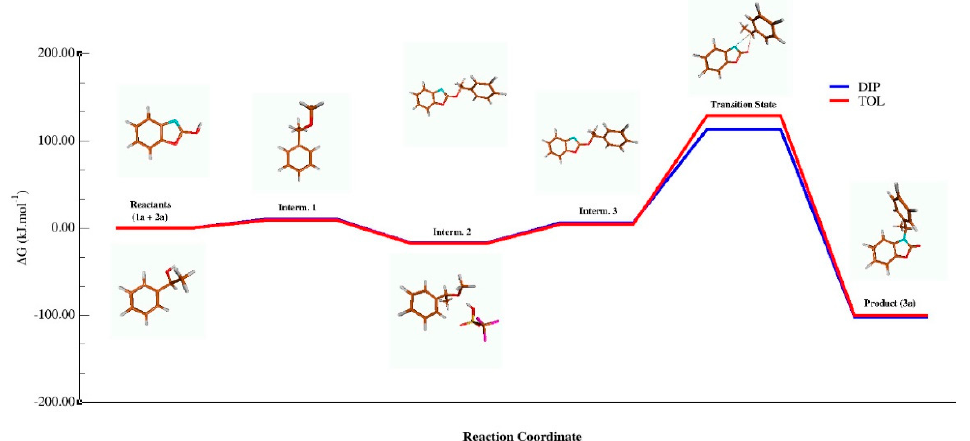
Figure 7. Potential energy surface involving the cooperative catalytic effects of MeOTf compared to TfOH using solvents toluene and diisopropylether .